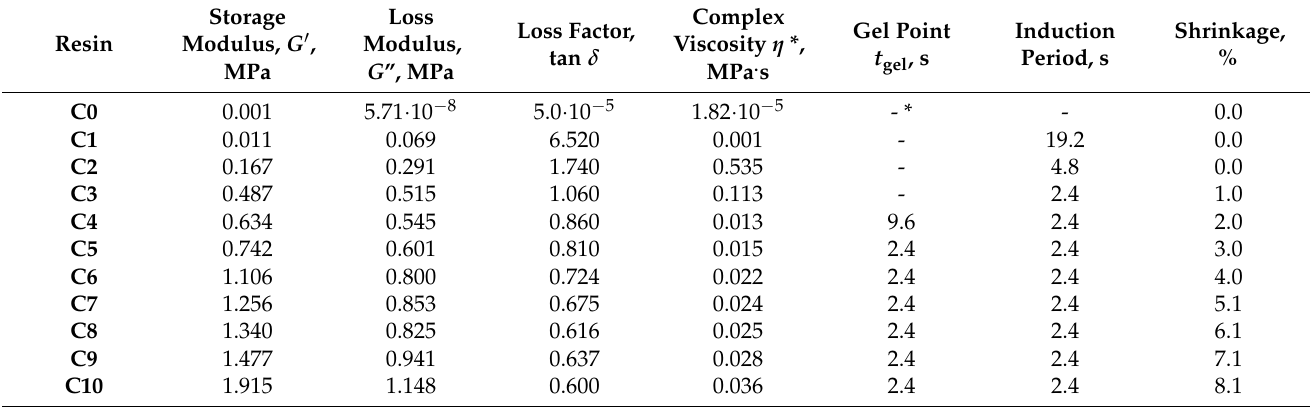
Table 2. Rheological characteristics of resins C0 – C10